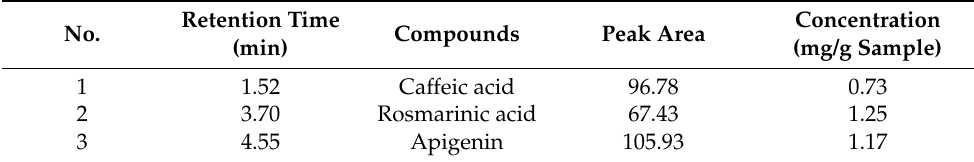
Figure 2. High-performance liquid chromatography of Coleus amboinicus ethanolic extracts. Table 2. Retention time, peak area, and concentration of compounds identified in Coleus amboinicus ethanolic extracts using high-performance liquid chromatography.